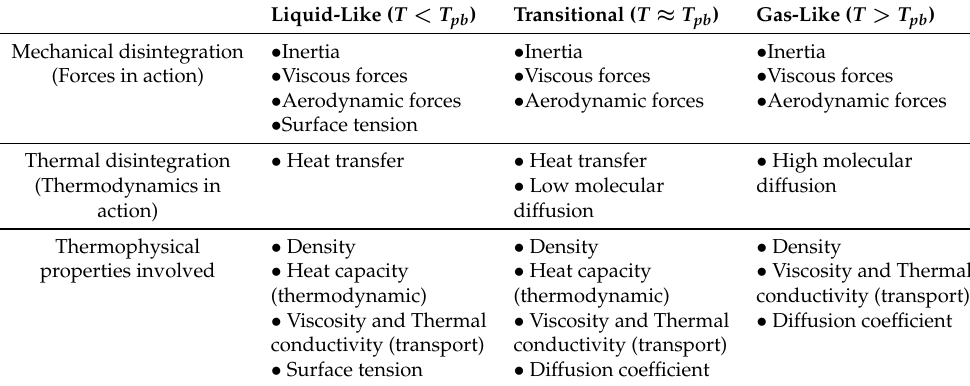
Table 1. Table of thermodynamic and mechanical forces and mechanism in action for various phases of fluid at supercritical